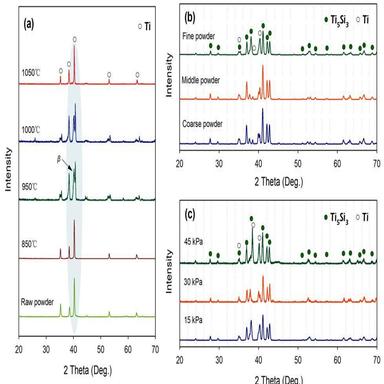
XRD patterns of samples fabricated under different conditions: (a) Ti substrates obtained at different sintering temperatures; (b) porous membranes prepared by different powders sintered at 1000 ℃ with the external load pressure of 30 kPa; (c) porous membranes prepared by middle powder sintered at 1050 ℃ with different load pressures: 15 kPa, 30 kPa and 45 kPa.